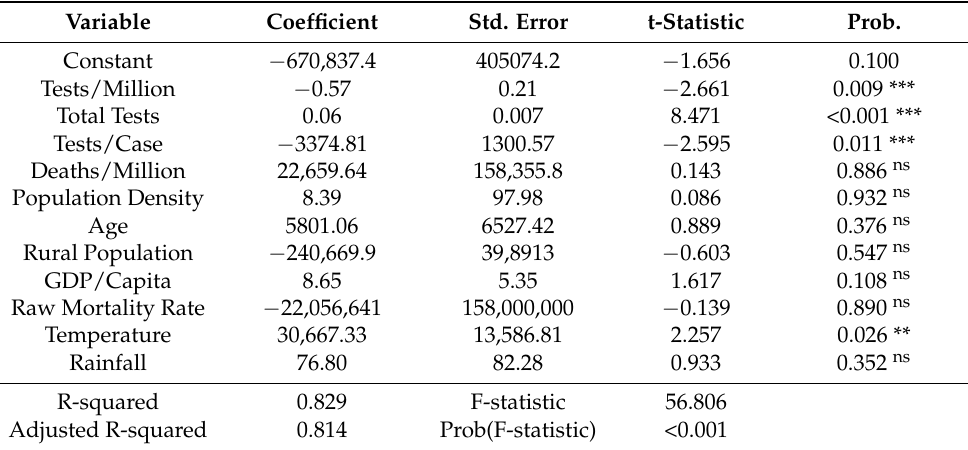
Table 3. Result of ordinary least squares (OLS) regression analysis on factors affecting number of cases of coronavirus disease 2019 (COVID-19, based on 10 December 2020 data).